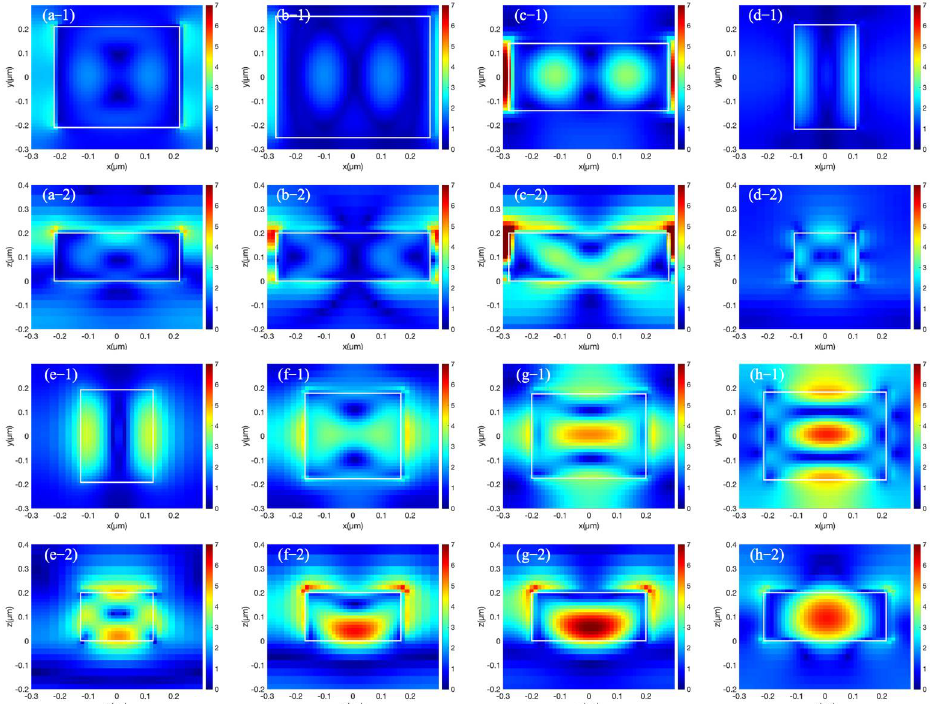
Figure 4. Electric field distributions of the eight selected unit-cells with nanobricks: ( a − 1 − h − 1 ) Normalized electric field distribution on the x−y plane with z = 100 nm; ( a − 2 − h − 2 ) Normalized electric field distribution on the x−z plane with y = 0 nm.